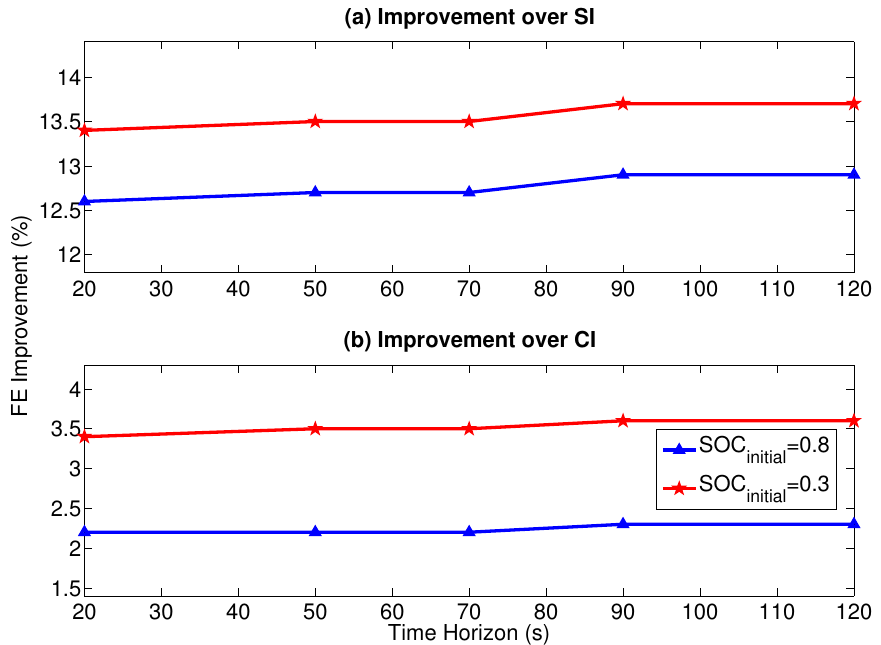
Figure 18. Fuel economy (FE) improvement by using the RCCI engine over the ( a ) SI or ( b ) CI at two initial SOC operating conditions (EMC: 3-mode